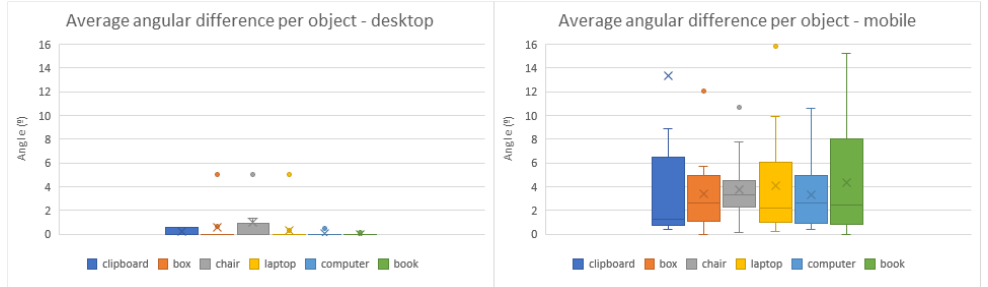
Figure 13. Box plots of the average angular difference from each virtual object placed to its target position in the desktop ( left ) and mobile ( right )